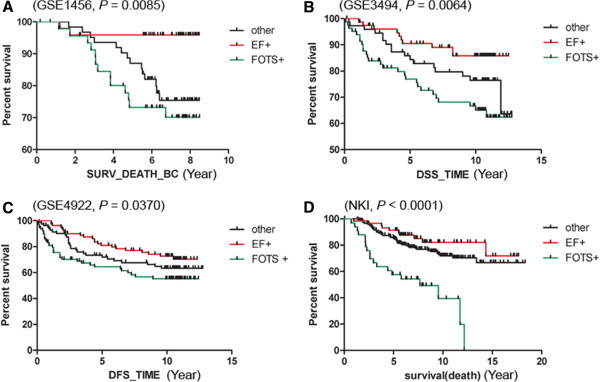
Kaplan-Meier plot for breast cancer cases stratified by FOTS/EF core gene sets. The Kaplan-Meier survival curves are tested by the Log-rank (Mantel-Cox) Test to determine the statistical significance of association of EF+, FOTS + or other breast cancers with overall survival (A, P = 0.0085), disease specific survival (B, P = 0.0064), disease free survival (C, P = 0.0370), and overall survival (D, P <0.0001) within the four breast cancer datasets, respectively.